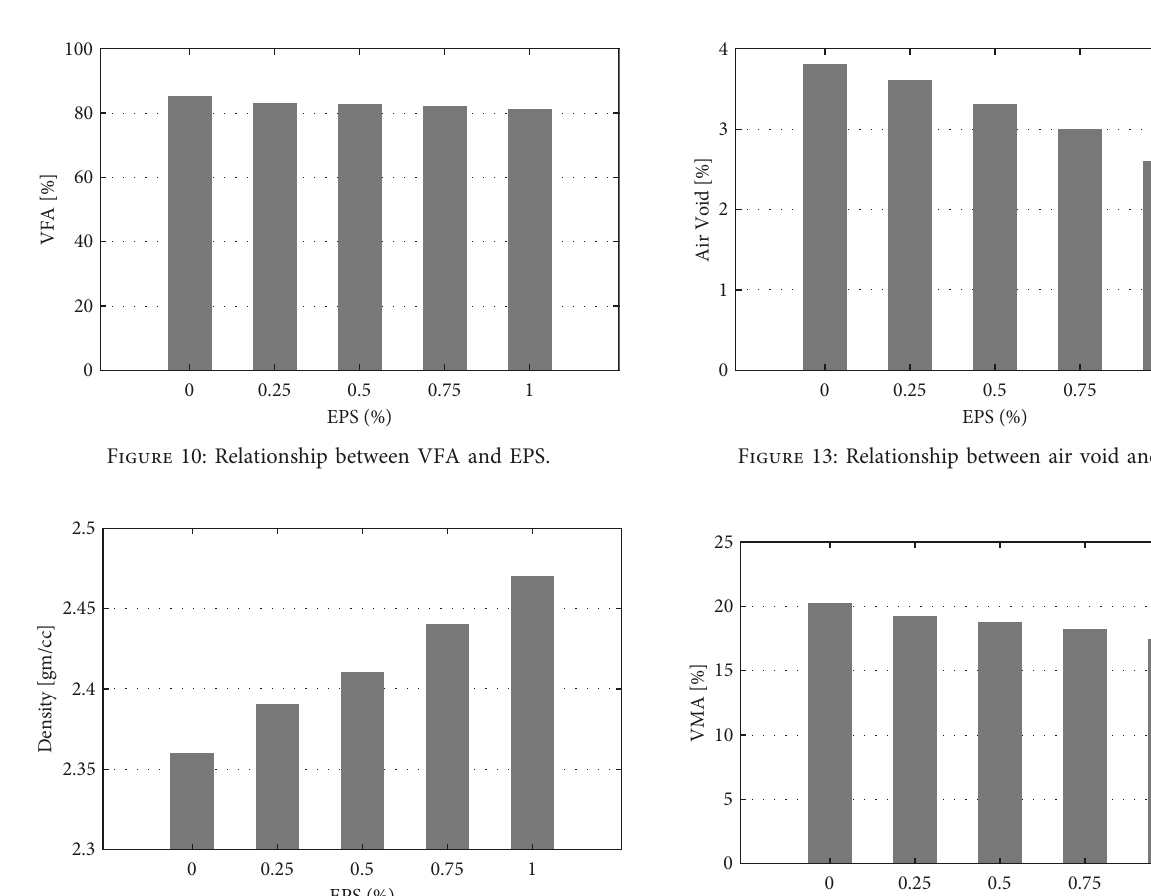
Figure 12: Relationship between flow value and EPS.